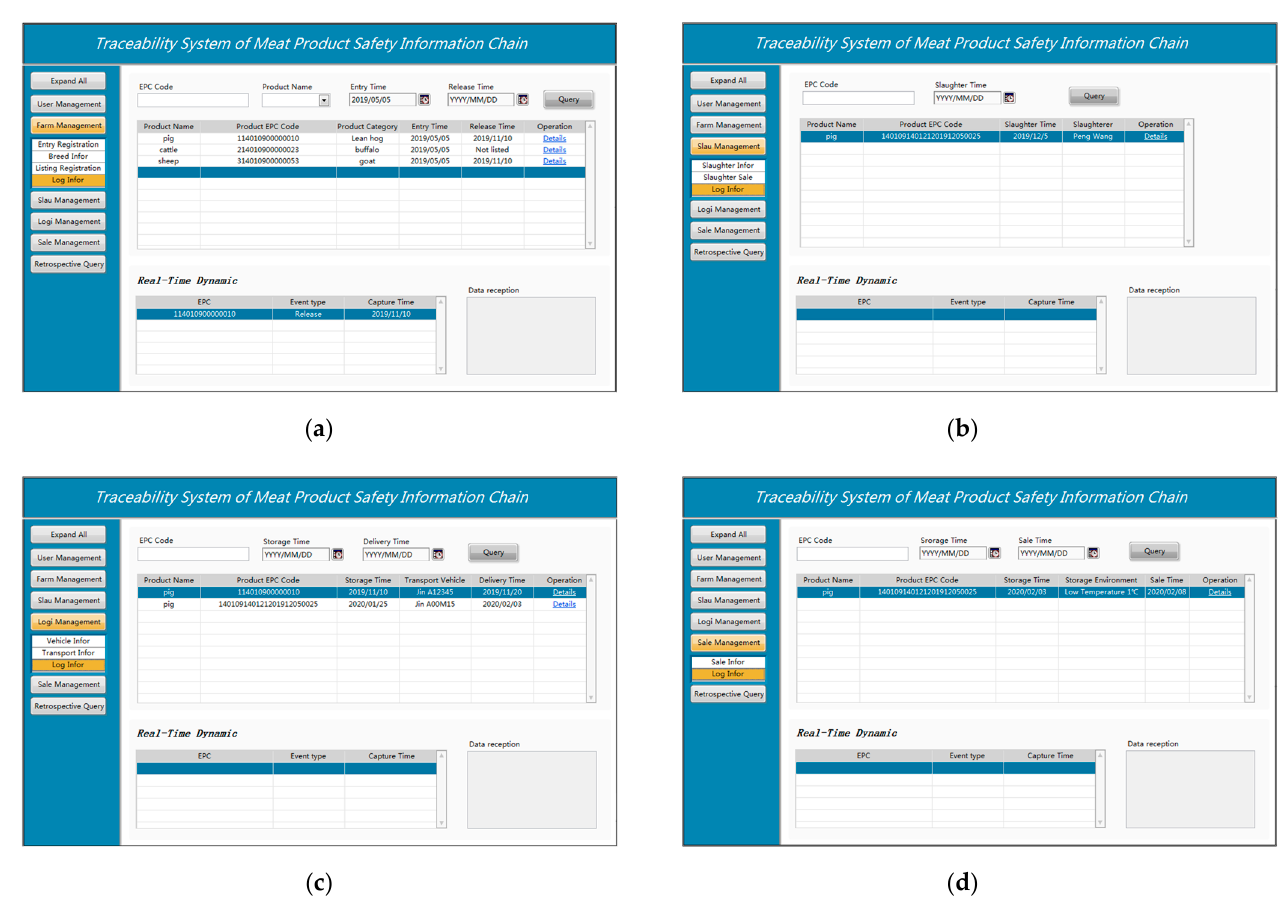
Figure 12. ( a ) Log query of farm management; ( b ) Log query of slaughter management; ( c ) Log query of Logistic management; ( d ) Log query of sale management.